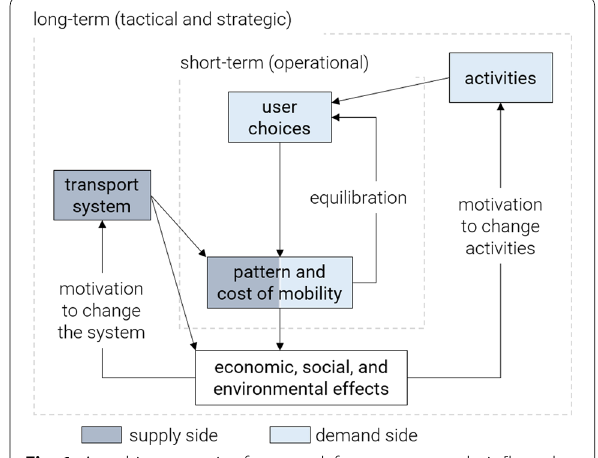
Fig. 1 A multi-perspective framework for transport analysis [based on 3, 53]